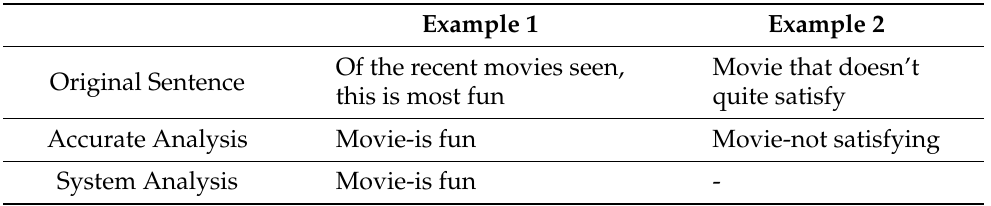
Table 6. Incorrect analysis